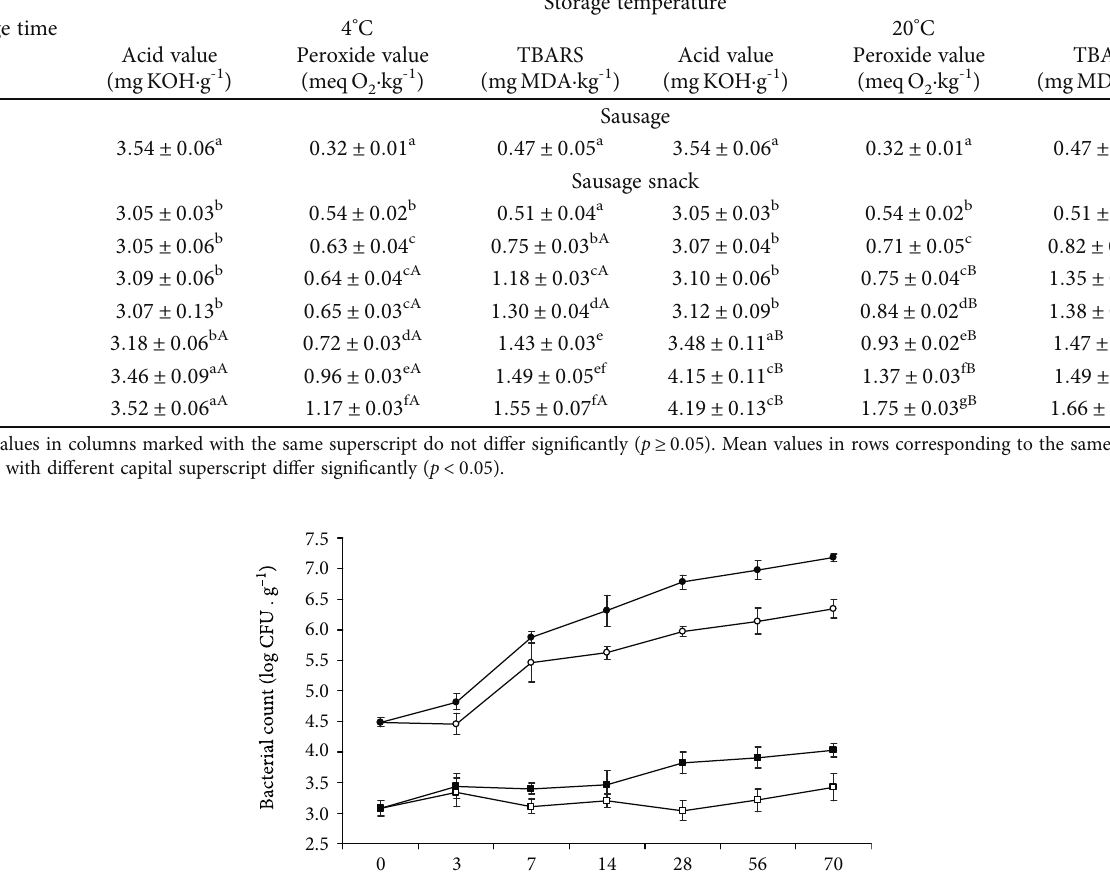
Table 4: E ff ect of drying and storage in MAP (20% CO Storage